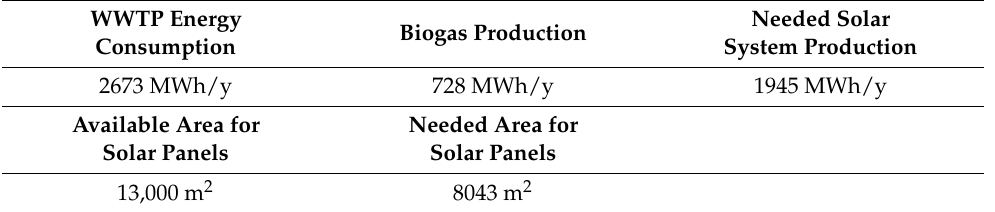
Table 4. Calculation of energy system options in the model WWTP.